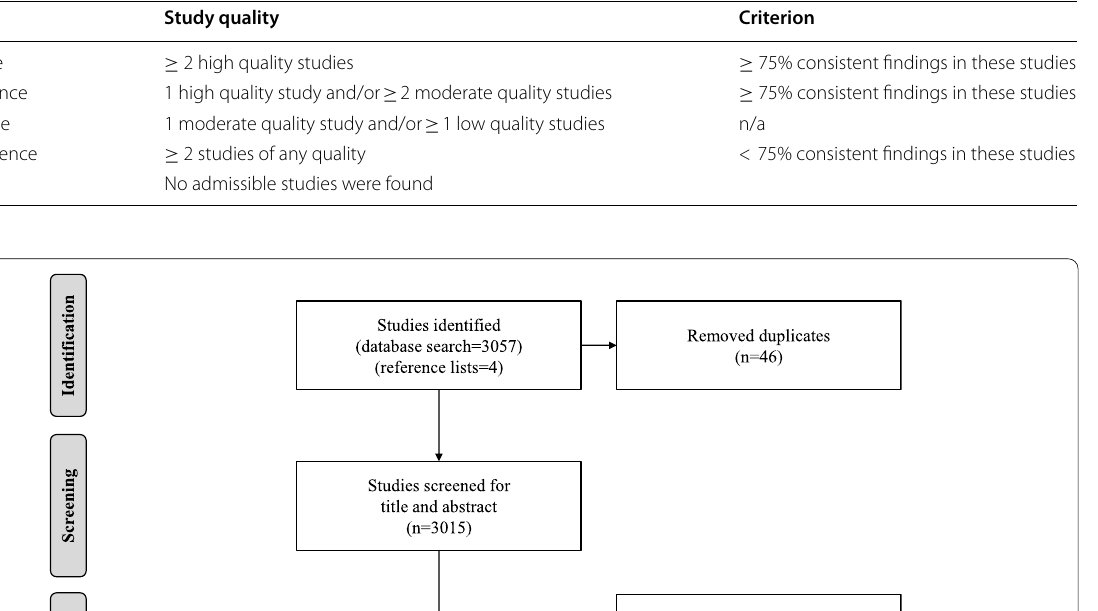
Table 1 Criteria for the best-evidence synthesis